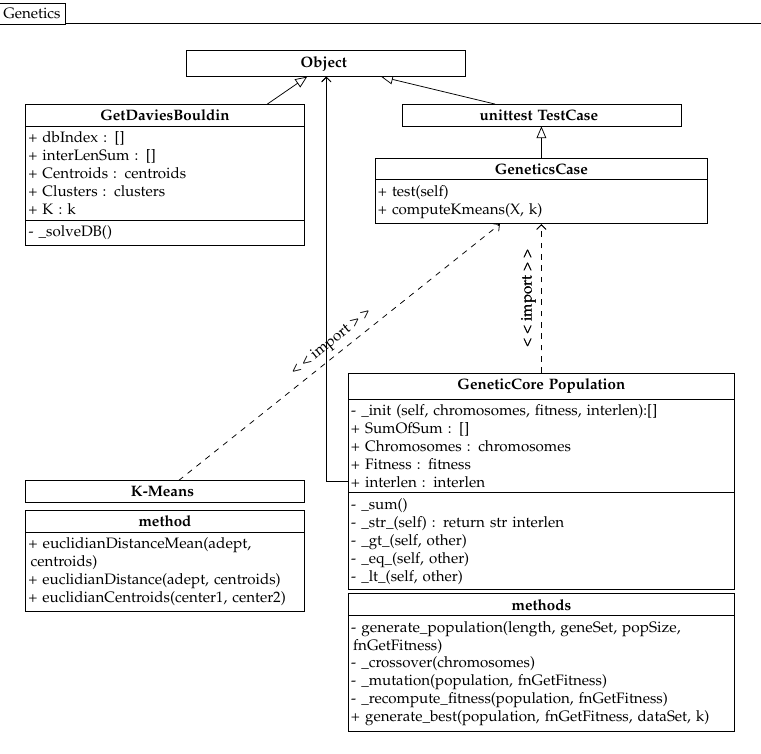
Figure 3. Partial GeneticsCore.py class